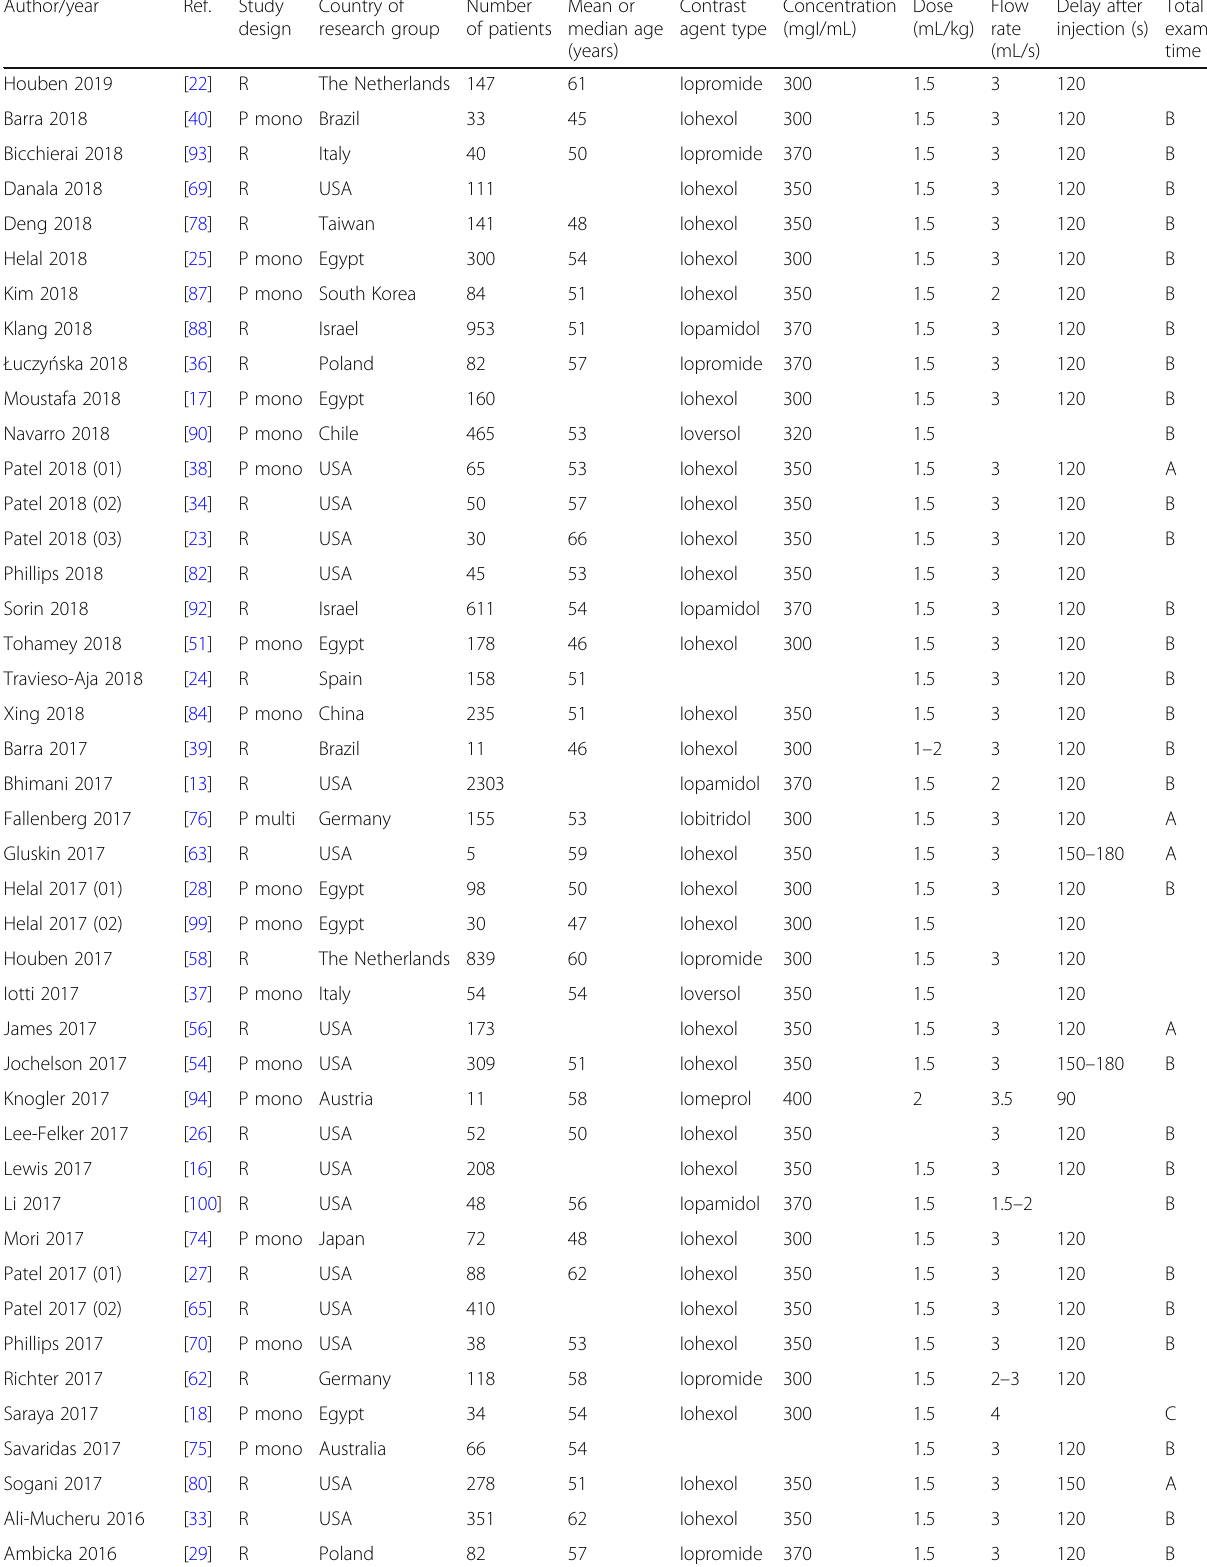
Table 1 Main characteristics of the 84 analysed